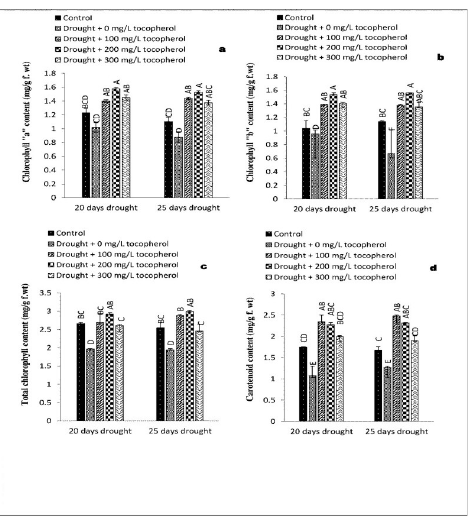
Fig 4. Effect of varying levels of exogenously applied α -tocopherol on chlorophyll “a” content ( a ) chlorophyll “b” content ( b ) total chlorophyll content ( c ) carotenoid content ( d ) of lentil ( Lens culinaris Medik.) grown under varying drought stress condition (Mean ± standard error.) letters (A–F) indicating least significance difference among the mean values at p �